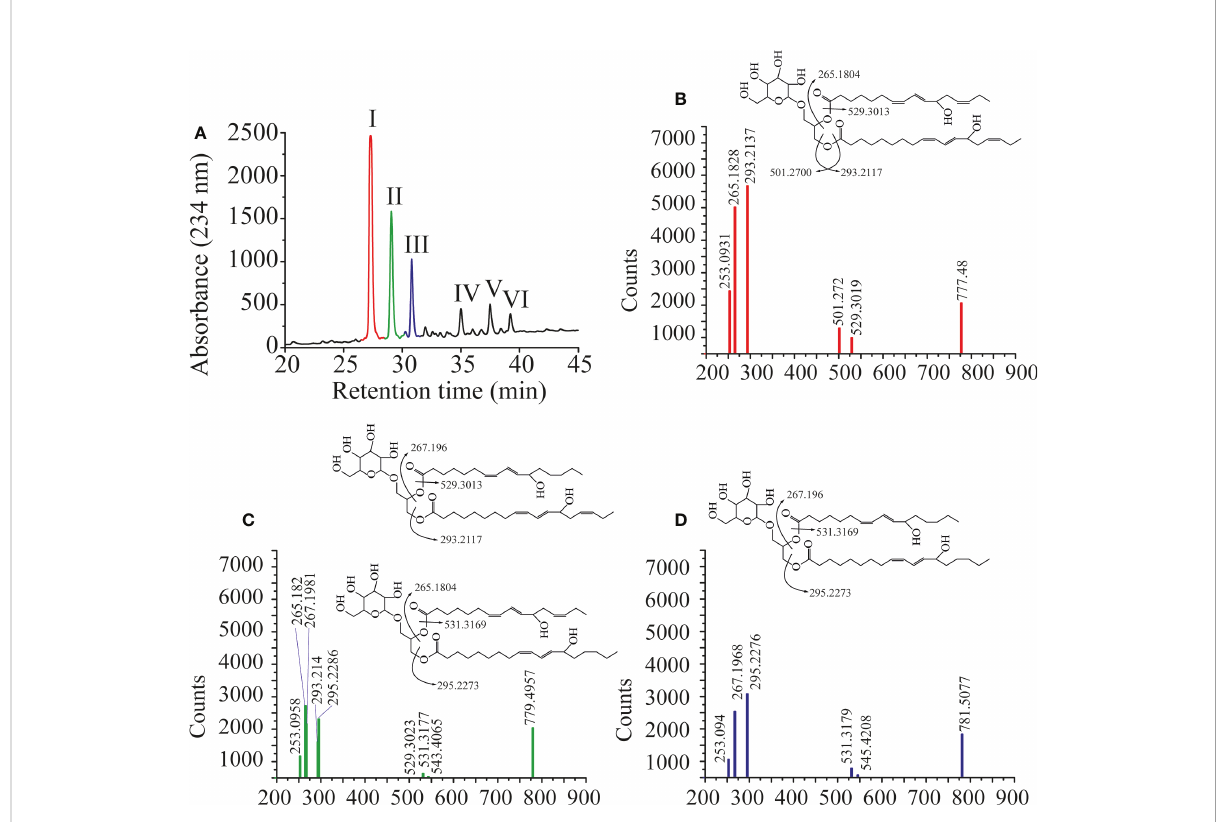
FIGURE 5 Oxidation products of LiLOX with MGDG isolated from L. incisa . (A) RP-HPLC of all oxidation products after chemical reduction. Six peaks were identi fi ed, named I, II, III, IV, V, and VI. B-D. Fragmentation pattern of the puri fi ed features I, II and III obtained by LC-MS/MS. The position of the hydroxyl groups on the chemical structures shown are tentatively assigned. (B) Peak I. (C) Peak II. (D) Peak III. Data shown represent a single